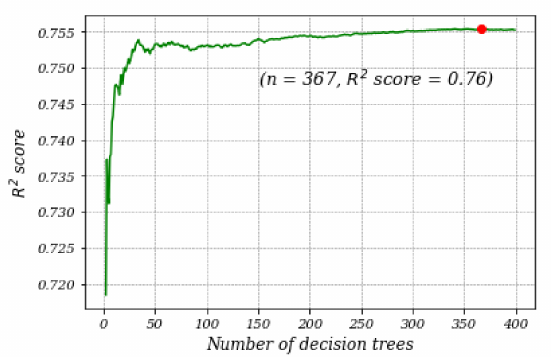
Figure 5. Choosing the optimal number of trees for the RF model.